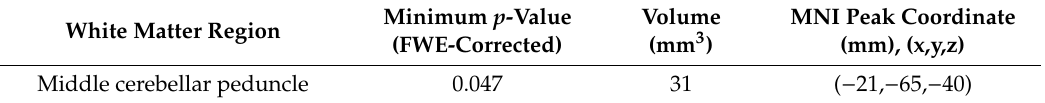
Figure A2. RTAP alterations between CM and HC including time from onset of CM as a covariate. TBSS showed decreased RTAP values in CM with respect to HC throughout the right hemisphere. The white matter skeleton is shown in blue, and voxels with the lowest p -values in red-yellow. The color bar shows the 1-p-values (FWE-corrected). Table A6. White matter regions from the ICBM-DTI-81 White Matter Atlas for which significant decreased AD values were found in CM compared to EM including the duration of the migraine, presence of aura and medication overuse headache as covariates.